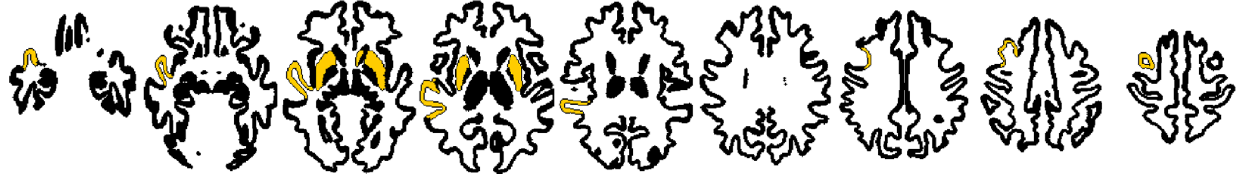
Figure 2. Fluid Ability. Locations where the mediating effect of age group on fluid ability via gray matter volume/thickness is significantly moderated by lifetime exposures. The black underlay is the Freesurfer parcellation of all 84 cortical and subcortical brain regions tested in these analyses. If a brain parcellation is significant at p(FDR) , 0.05 it is colored yellow.